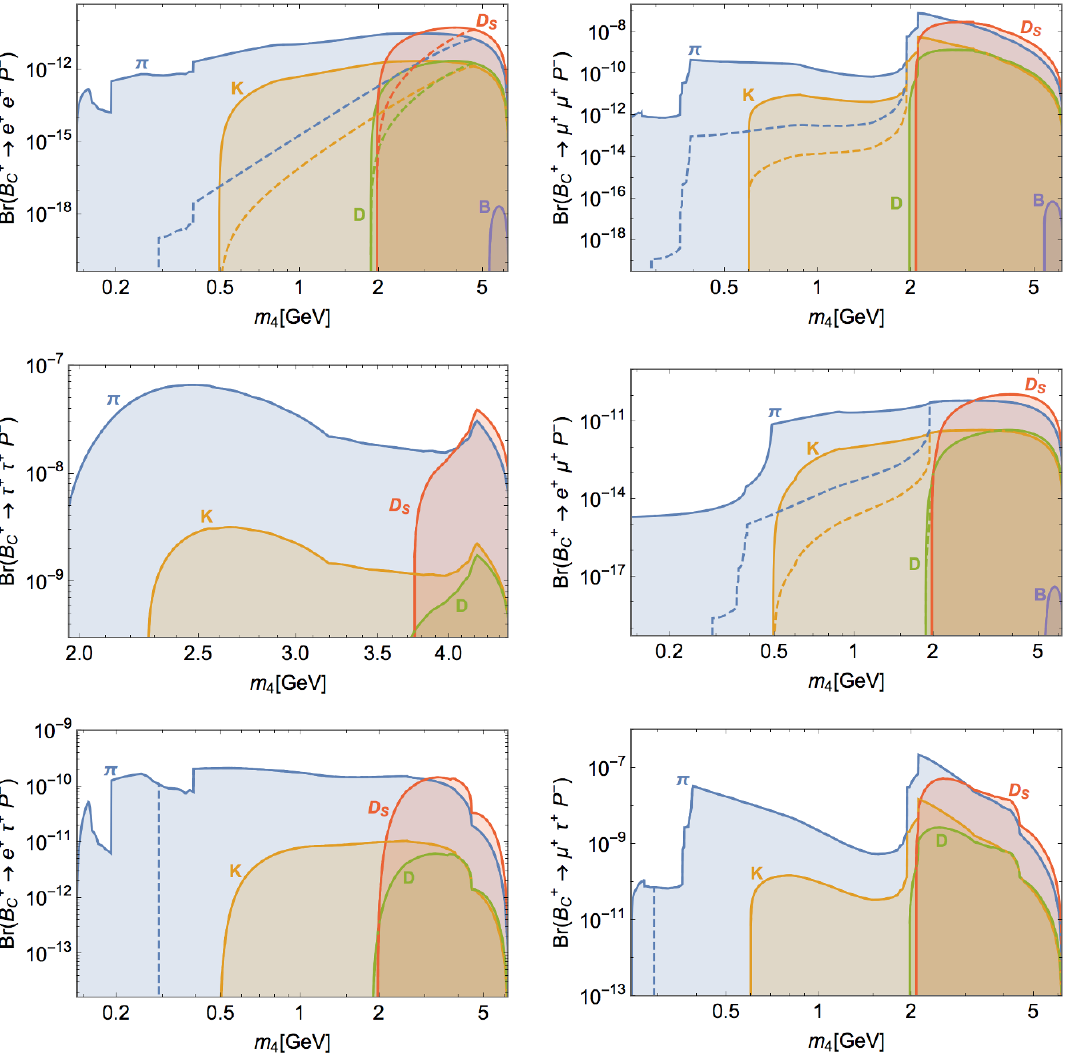
Figure 10 . Branching ratios of LNV decay modes of B + mesons (into pseudoscalar (cid:12)nal states, plus c leptons of same or di(cid:11)erent (cid:13)avour), as a function of the (mostly sterile) heavy neutrino mass, m 4 . Pale blue, yellow, red, green and blue curves (surfaces) respectively denote the maximal (allowed) values of the BR( B + ! ‘ (cid:11) ‘ (cid:12) P (cid:0) ), with M (cid:0) = (cid:25) (cid:0) , K (cid:0) , D (cid:0) , D (cid:0) and B (cid:0) ; coloured dashed curves c s denote the corresponding maximal values of the BRs once c(cid:28) 4 (cid:20) 10 m is imposed.